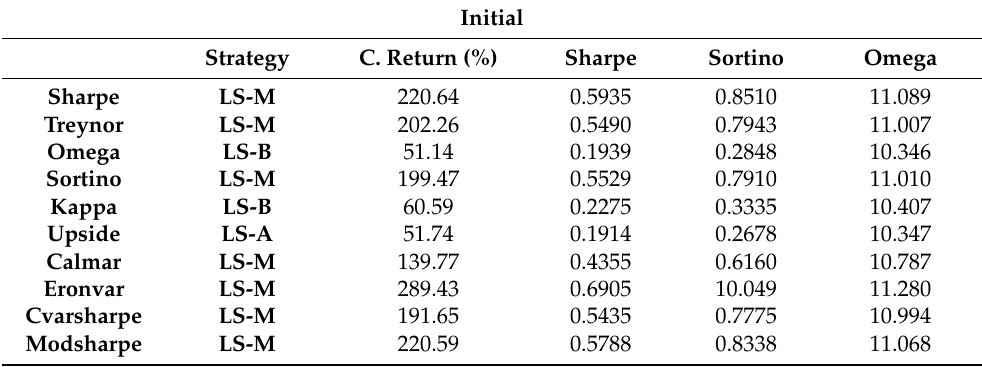
Table 6. Performance evaluation from the strategies using the initial and standardized